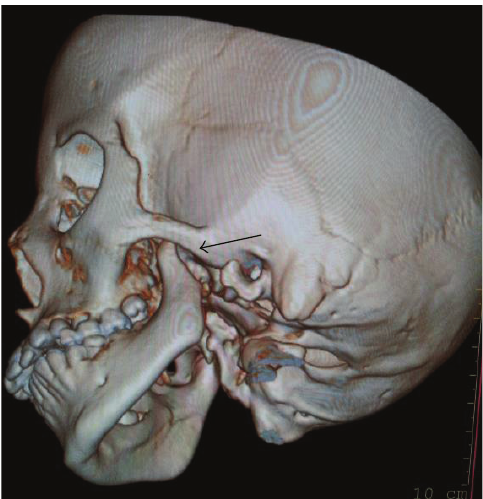
Figure 6: 3D CT scan of normal side (right) with normal condyle and glenoid